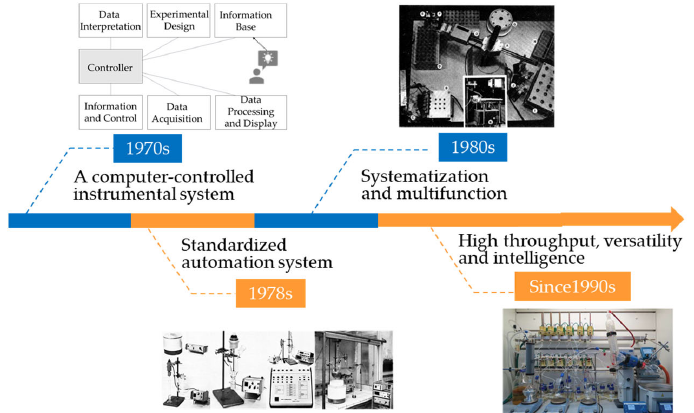
Figure 2. Development of automated chemical synthesis platform. Picture in 1970s adapted